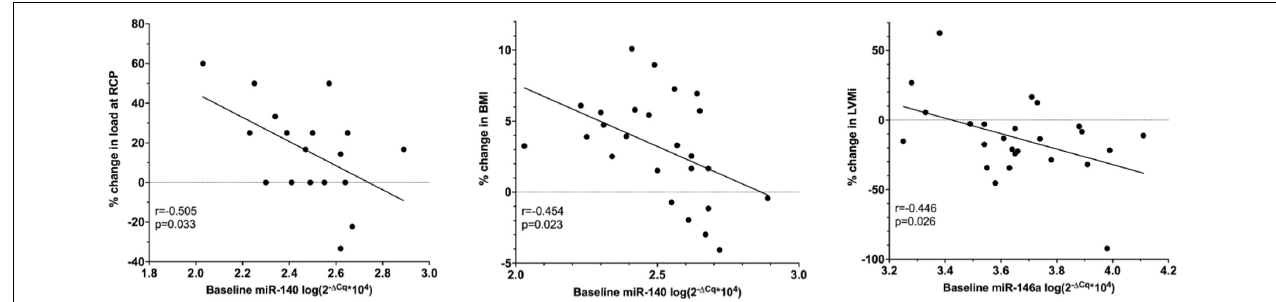
FIGURE 5 | Pearson correlation of baseline relative miRNA expression, the percent change in LVMi, percent change in load at RCP and the percent change in BMI in ET only. BMI, body mass index ( n = 25); LVMi, left ventricular mass index ( n = 25); RCP, respiratory compensation point ( n = 18).